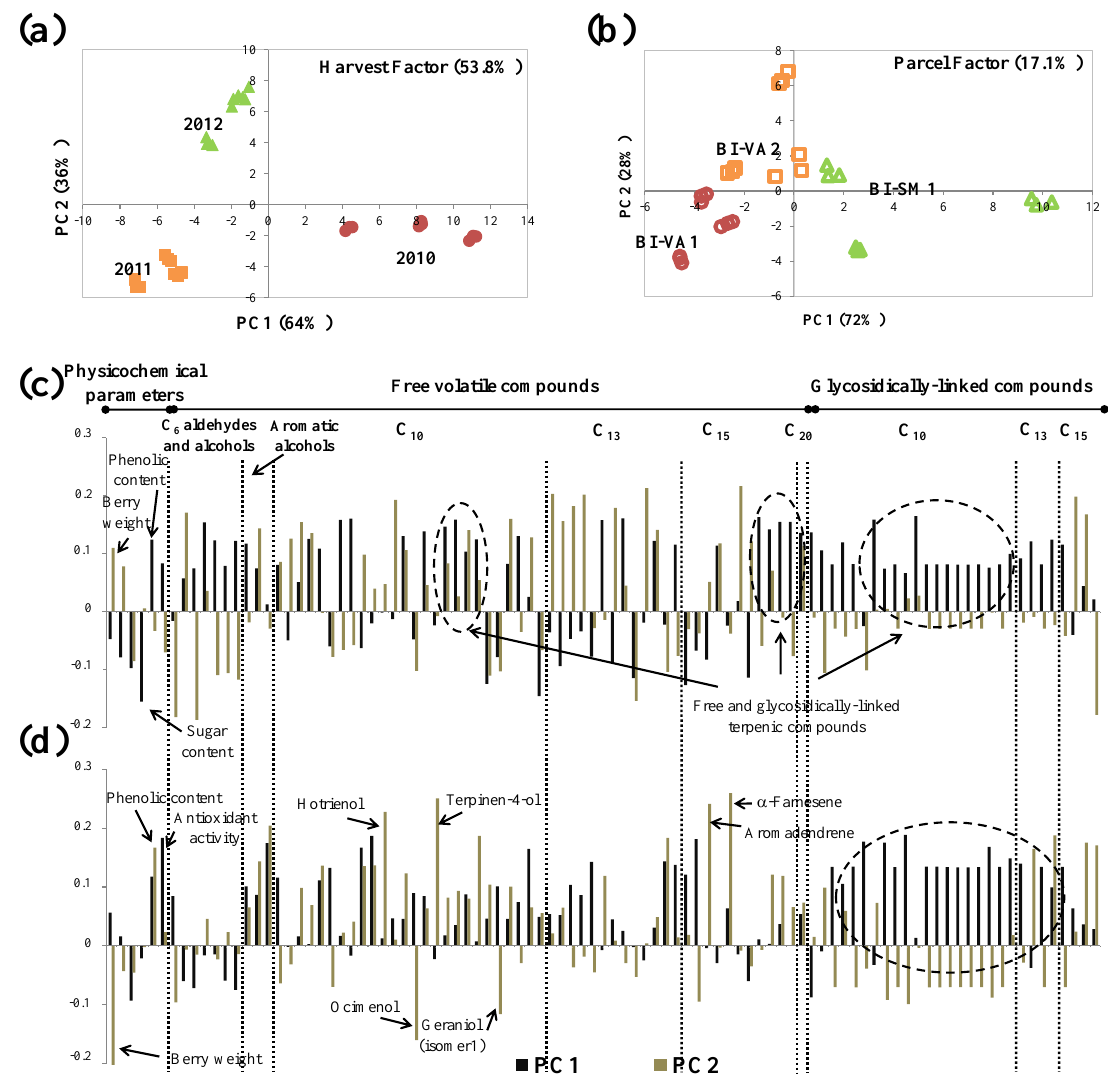
Figure 5. ASCA scores plot for ( a ) harvest and ( b ) parcel factors, and the corresponding variable loadings plot ( c , d ), respectively, obtained for Bical, at technological maturity (significance test reported on Table 4). Each variable is normalized separately by dividing by its standard deviation value.